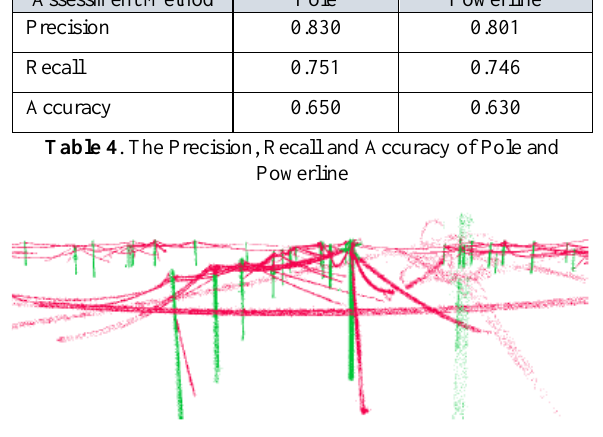
Figure 6 . The extracted result for pole and powerline after cleaning data